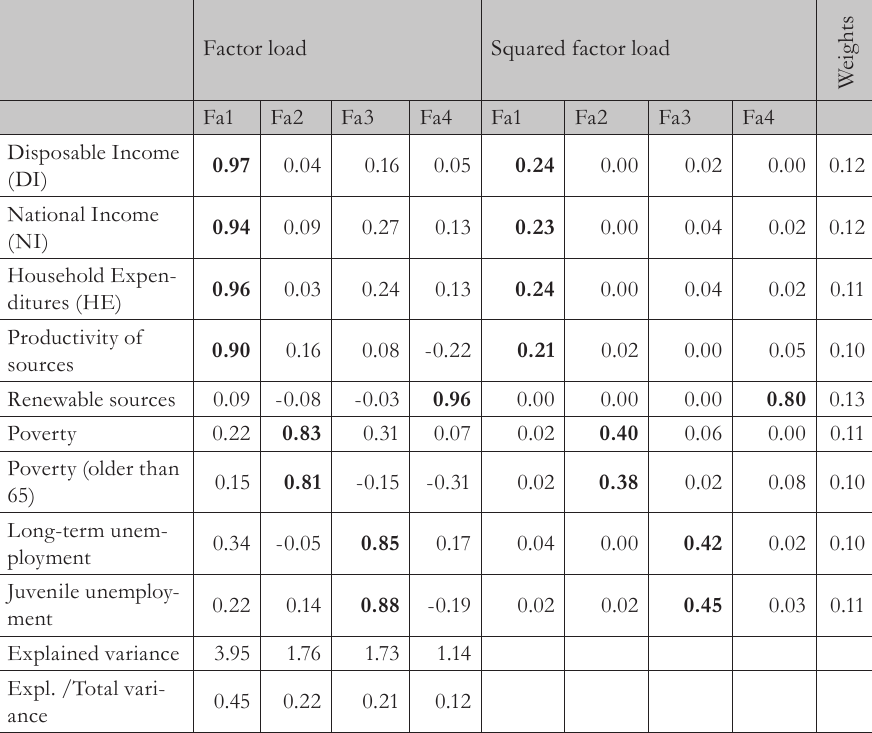
Tab. 4 – Factor analysis for efficient competitiveness of EU countries. Source: authors’ process- ing by Eurostat, AMECO, SPL, the World Bank